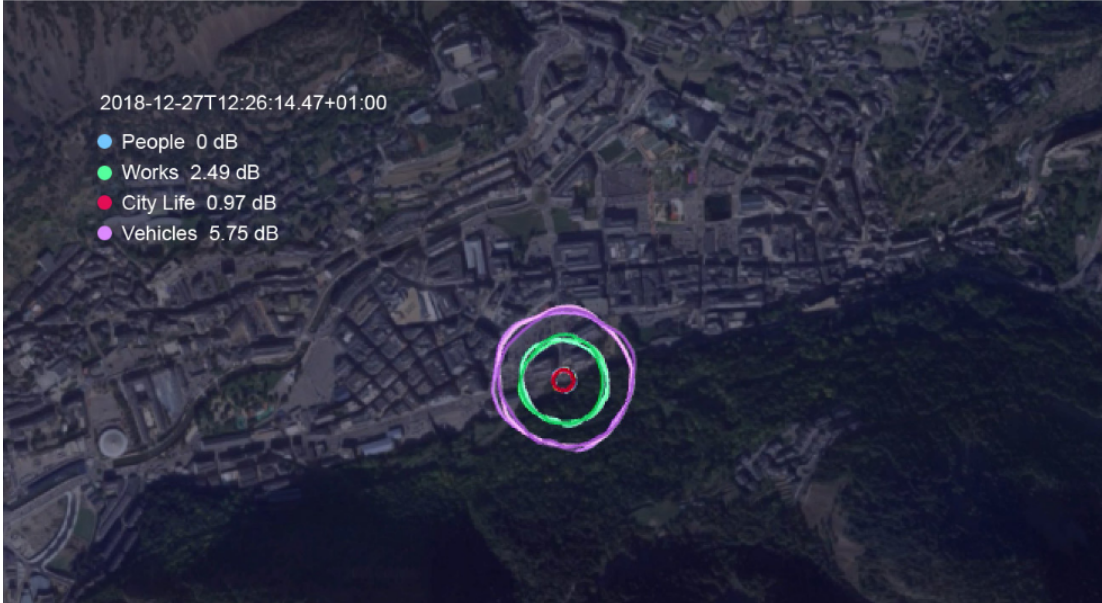
Figure 4. Single location noise event